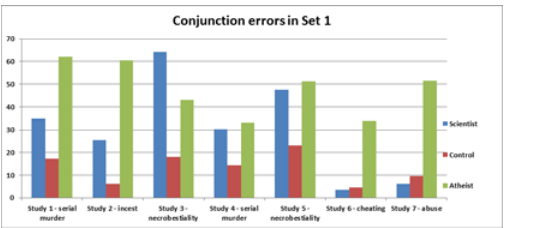
Fig 1. Conjunction error rates (percentages) in Studies 1 – 7 for each category of targets. All target groups differ at p < .01, except for scientist and atheist targets in Studies 4 – 5, and scientists and control targets in Studies 6 –